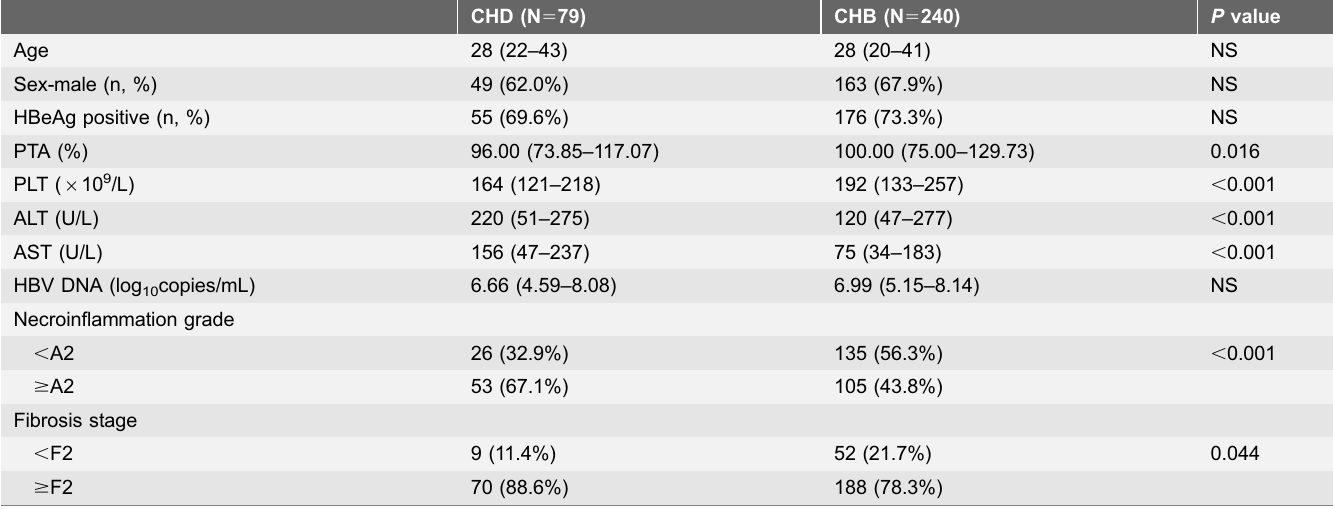
Table 3. Characteristics of CHD patients with liver biopsy.